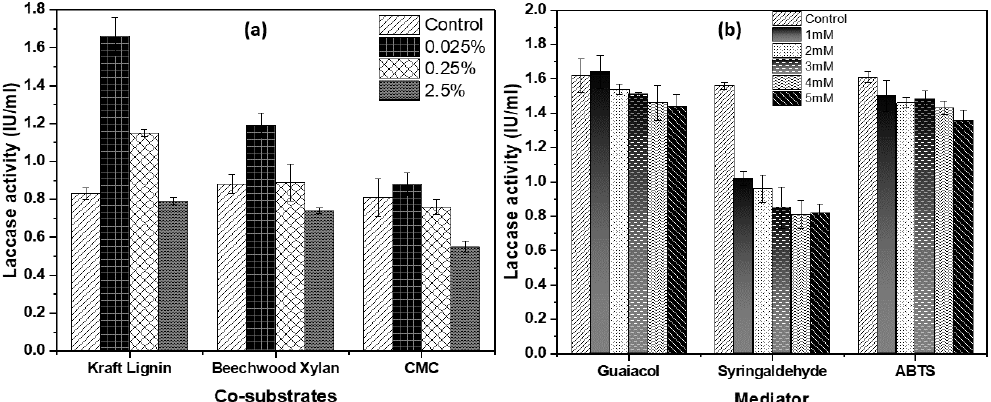
Figure 2. Effect of adding ( a ) co-substrates and ( b ) mediators on laccase induction in Geobacillus sp. strain WSUCF1 at 60 °C, pH 7.0, and agitation speed of 150 rpm, after 10 days of incubation with 0.5% (w/v) unprocessed corn stover (CS) as the carbon source. Here, CMC = Carboxymethyl cellulose, ABTS = 2,2’-azino-bis (3-ethylbenzothiazoline-6-sulfonic acid), IU = International Units. Note: All the experiments were performed in triplicates, with data averaged and presented as the mean ± standard deviation (SD).